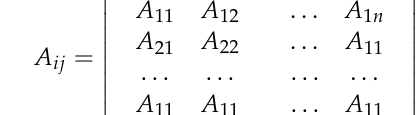
Unit Applied Scale Ecological Meaning Patch Describe the dominant class/landscape landscape Describing the degree of Patch class